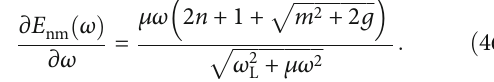
ffiffiffiffiffiffiffiffiffiffiffiffiffiffiffiffi ffiffiffiffiffiffiffiffiffiffiffiffiffiffiffiffiffiffi p ω 2 + μω 2 L